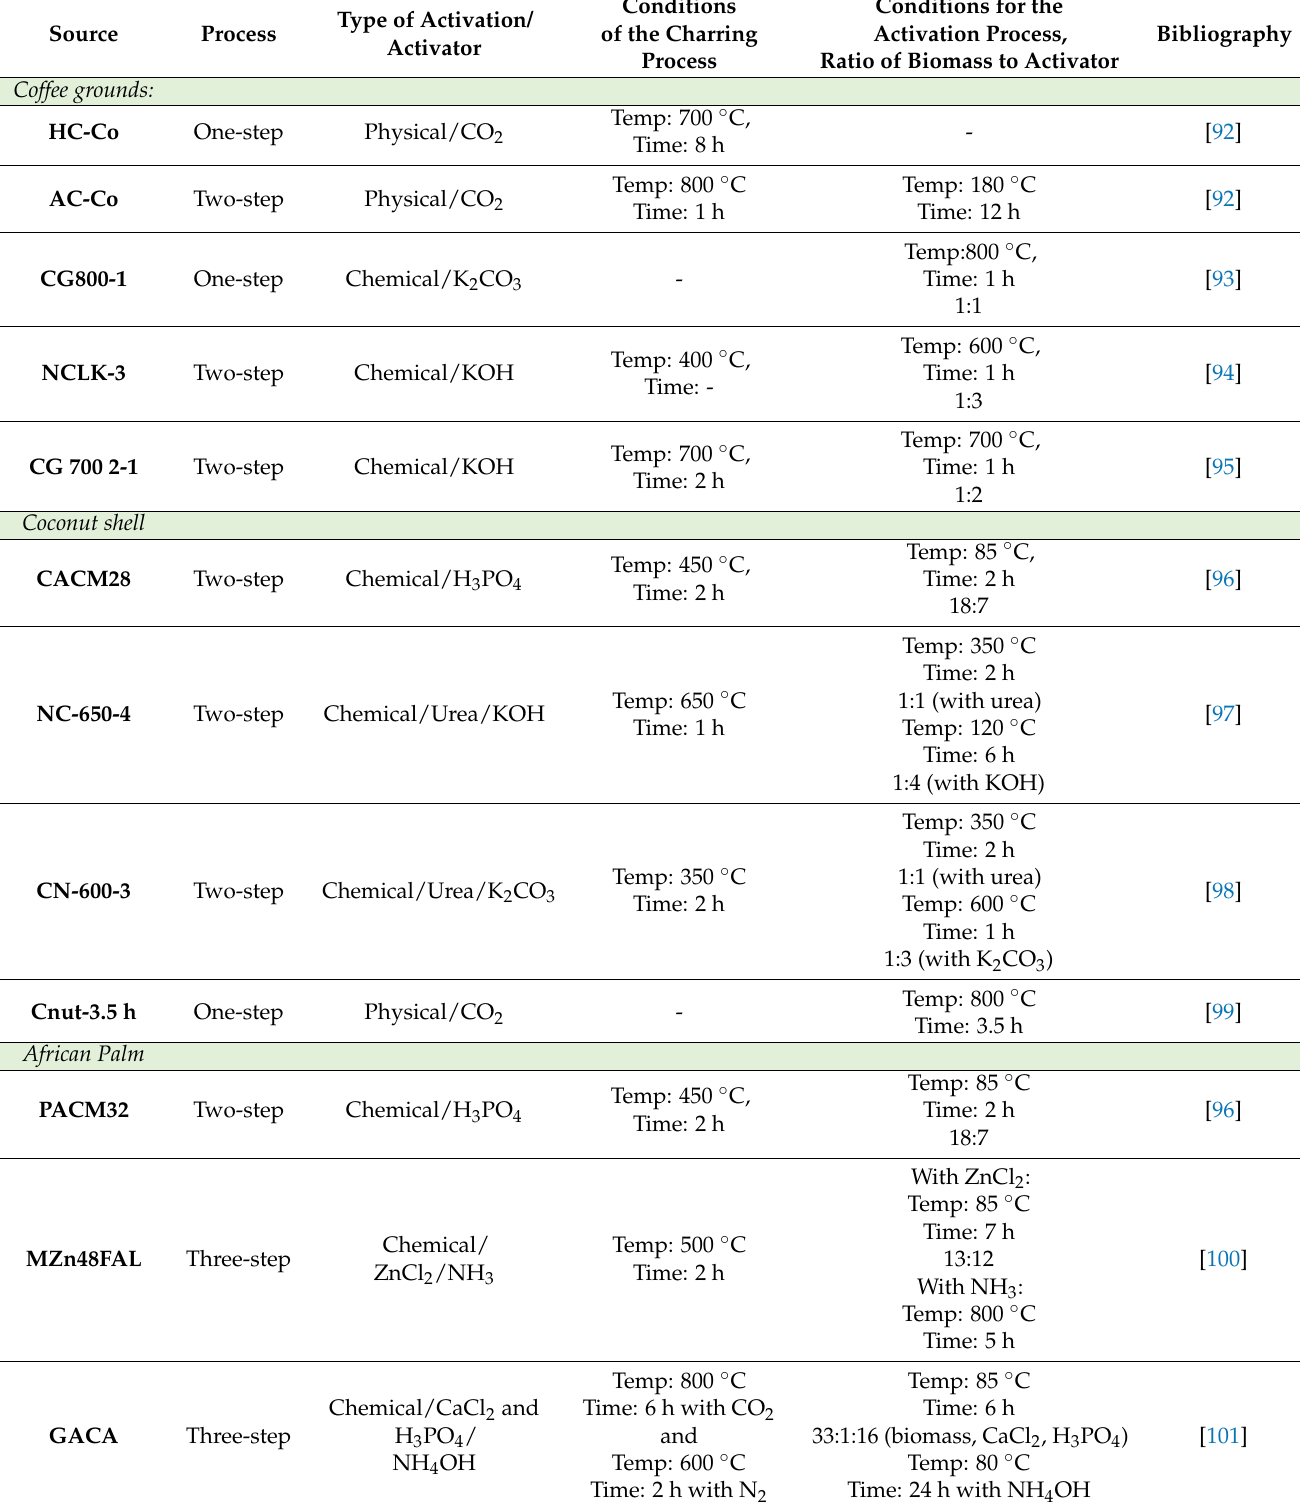
Table 3. Comparison of the conditions of the carbonization and activation of